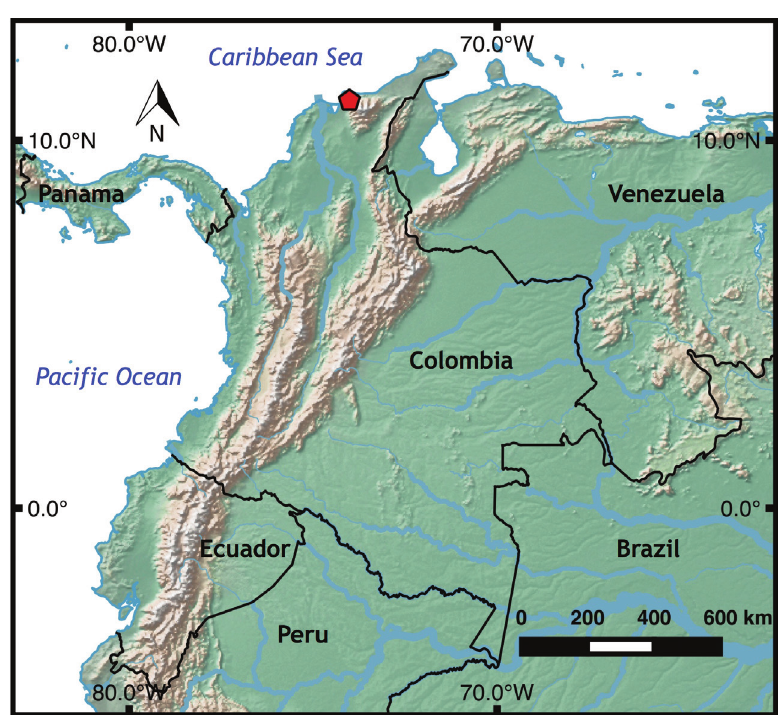
Figure 4. Distribution of Oreosaurus serranus sp. n. in the northwestern slopes of the Sierra Nevada de Santa Marta, northern Colombia. Pentagon indicates type